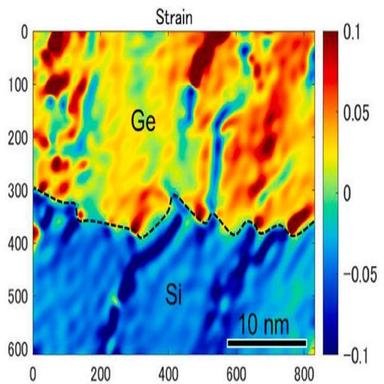
Strain localization and distribution of the Ge/Si crystal specimen using the transmission electron microscope moir´e method . The copyright permission for this figure has been granted.